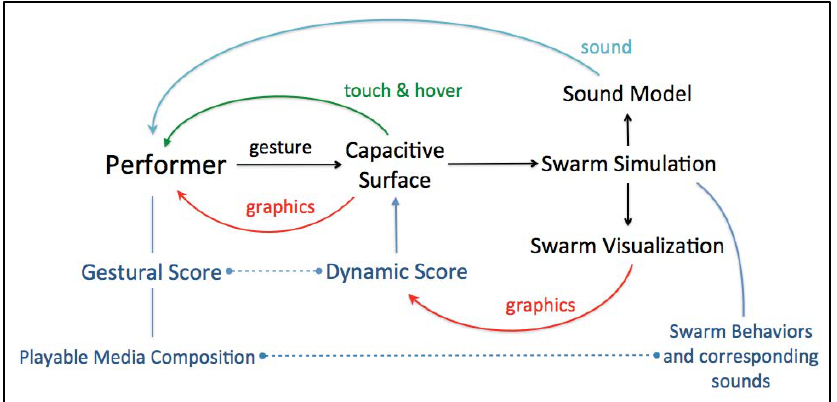
Figure 4: The system workflow diagram to show the function of Dynamic Score in a performance. Visual and auditory feedback is coupled to kinesthetic feedback of players’ upper bodies, arms and hands moving to near and far locations, both hovering above and touching the play surface